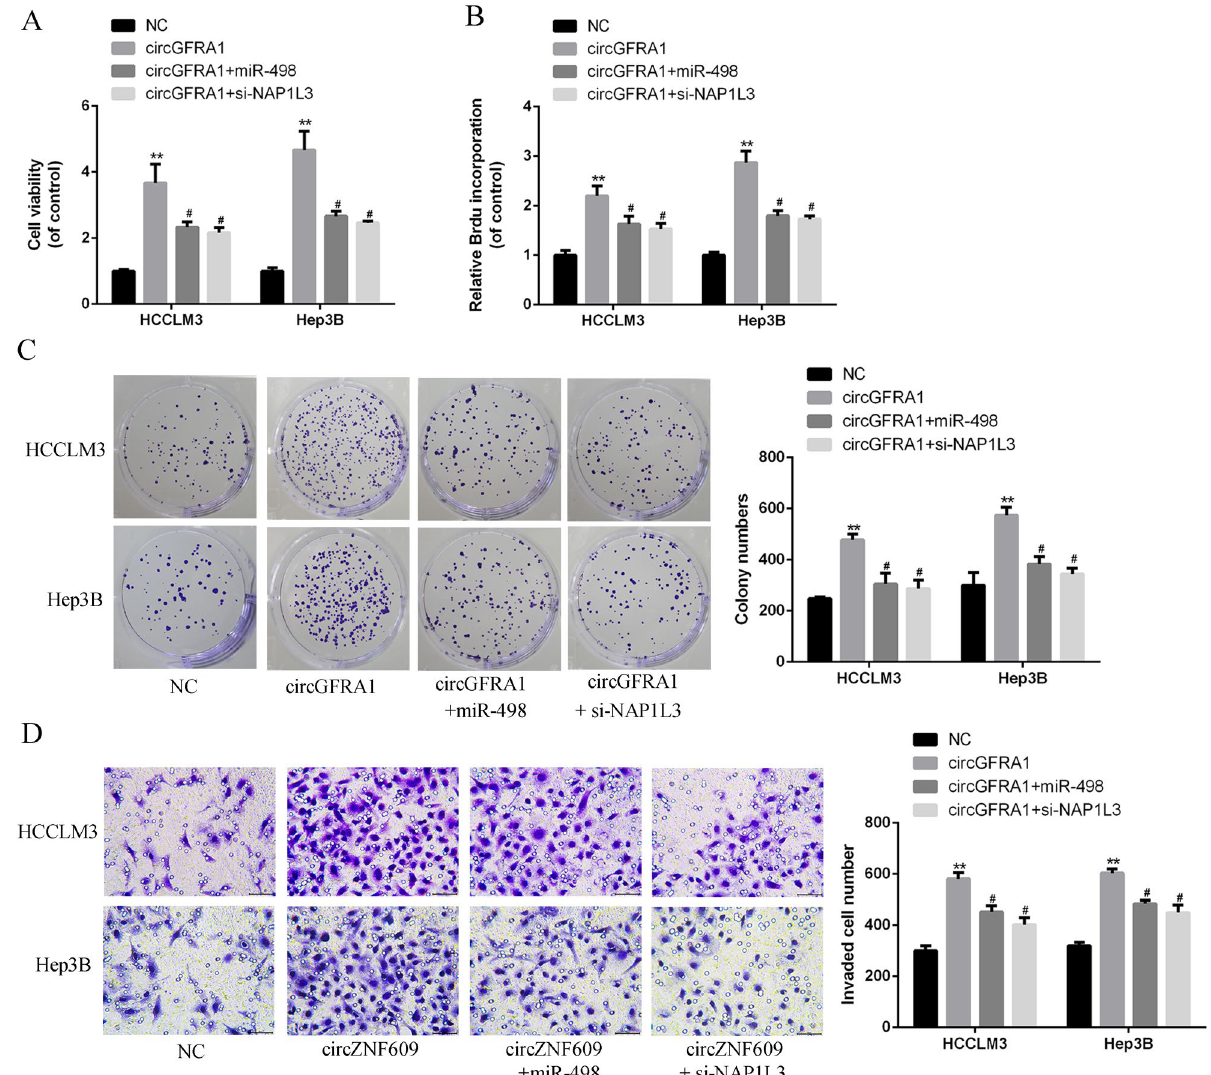
Figure 4. MiR-498 over-expression or NAP1L3 silencing effectively reversed circGFRA1-induced HCC progression. ( A ) CCK-8 assays of HCCLM3 and Hep3B cells co-transfected with circGFRA1 or control and miR-498 or si-NAP1L3. ( B ) Brdu incorporation assay of HCCLM3 and Hep3B cells co-transfected with circGFRA1 or control and miR-498 mimics or si-NAP1L3. ( C ) Colony formation assay of HCCLM3 and Hep3B cells co-transfected with circGFRA1 and miR-498 mimics or si-NAP1L3. ( D ) Transwell assay of HCCLM3 and Hep3B cells co-transfected with circGFRA1 or control vector, and miR-498 mimics or si-NAP1L3. Scale bar = 20 µm. *vs. control vector group, # vs. circGFRA1 group. **P < 0.01, # P <